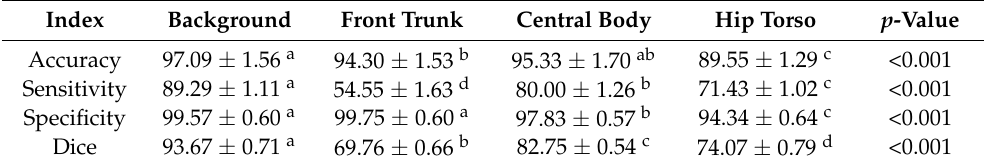
Table 2. Body-part detection performance parameters for side view of cattle (%) *.